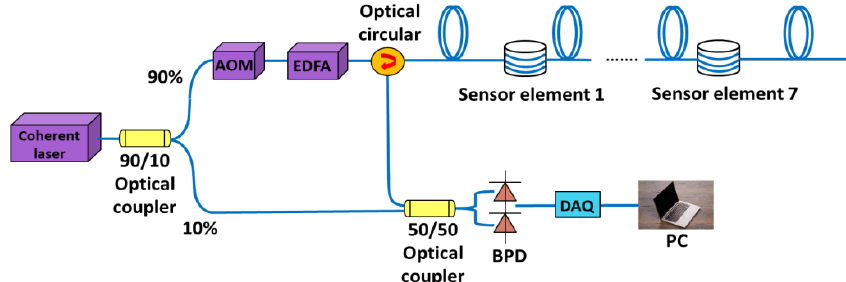
Figure 2. Experimental setup of a φ -OTDR sensing system incorporating with 3D-printed sensing elements: acoustic-optic modulator (AOM); erbium-doped fiber amplifier (EDFA); balanced photo- detector (BPD); data acquisition card (DAQ); and personal computer (PC).